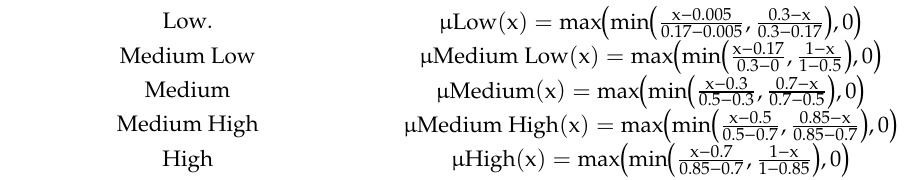
Table 2. Mathematical representation of the output membership